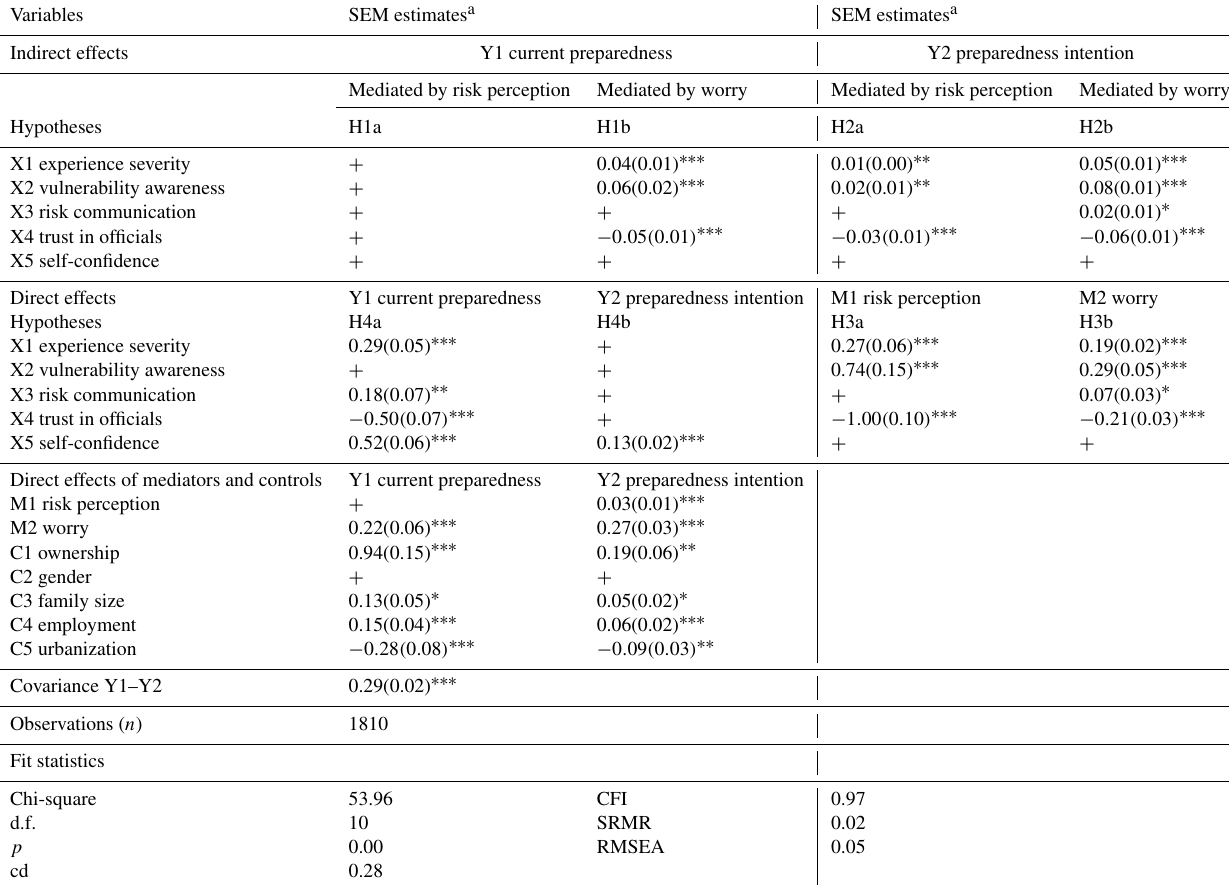
Table 7. Path analysis results and fit statistics.